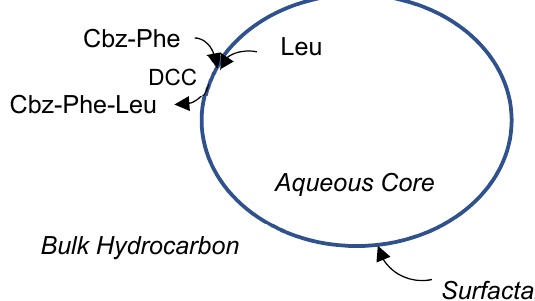
Figure 1. Schematic representation of dipeptide synthesis using a reversed